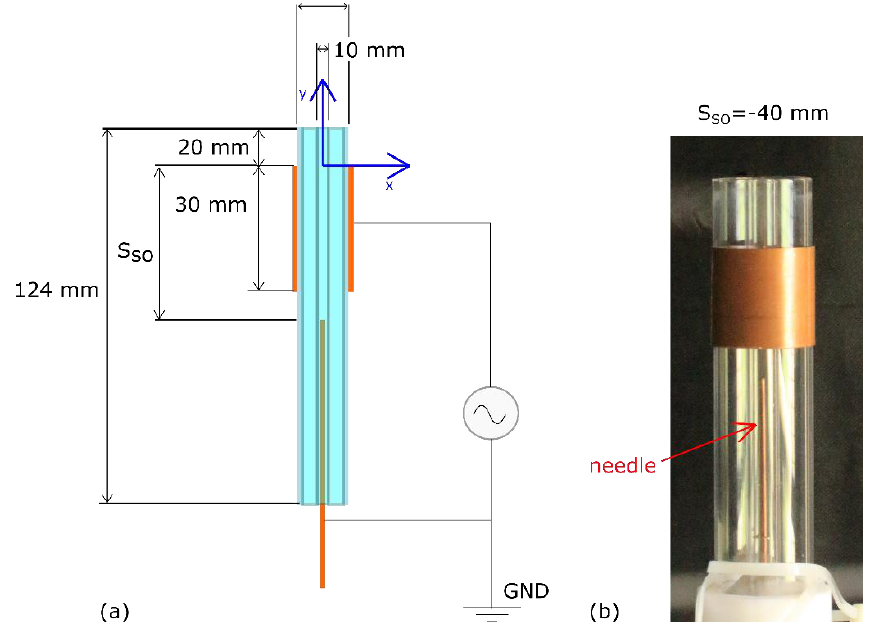
Figure 2. Coaxial dielectric barrier discharge plasma actuator (DBD-PA): ( a ) geometry and dimensions; ( b ) picture of the actual setup at stand-off distance S SO = − 40 mm.